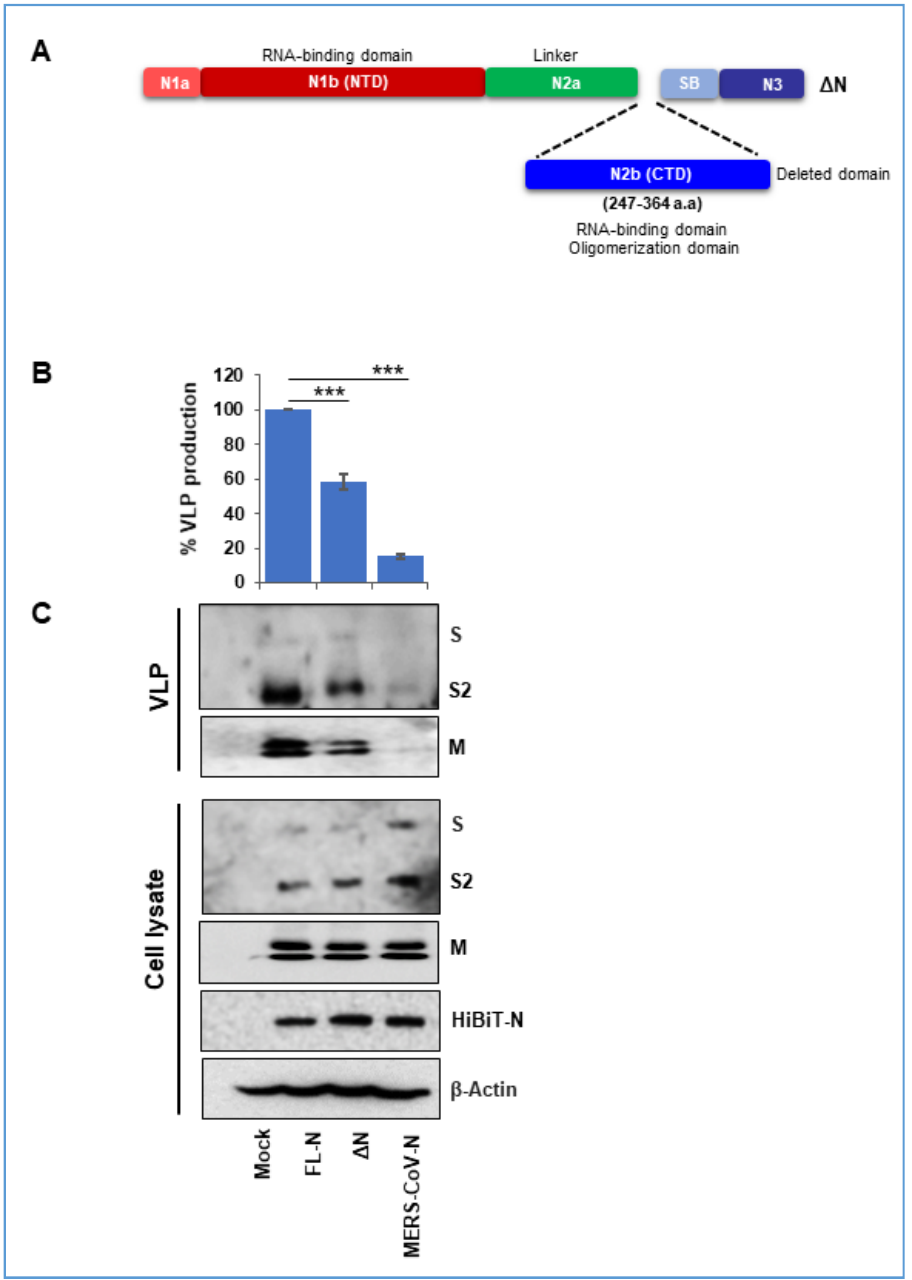
Figure 5. N proteins lacking CTDs interfere modestly with VLP production. ( A ) Schematic representation of CTD-deleted SARS-CoV2 N. ( B ) SARS-CoV2 N (FL-N) was cotransfected with S, E, and M plasmids, or in combination with CTD-deleted N, at 1:1 plasmid transfection ratio. The CTD-deleted N was not HiBiT-tagged. Yields of SEC-purified VLPs were determined by LgBiT complementation (NanoBiT technology. Results are means ± SE of three independent experiments. *** p < 0.001. ( C ) S, M, and N proteins in purified VLPs and cell lysates were detected by WB meth- ods.